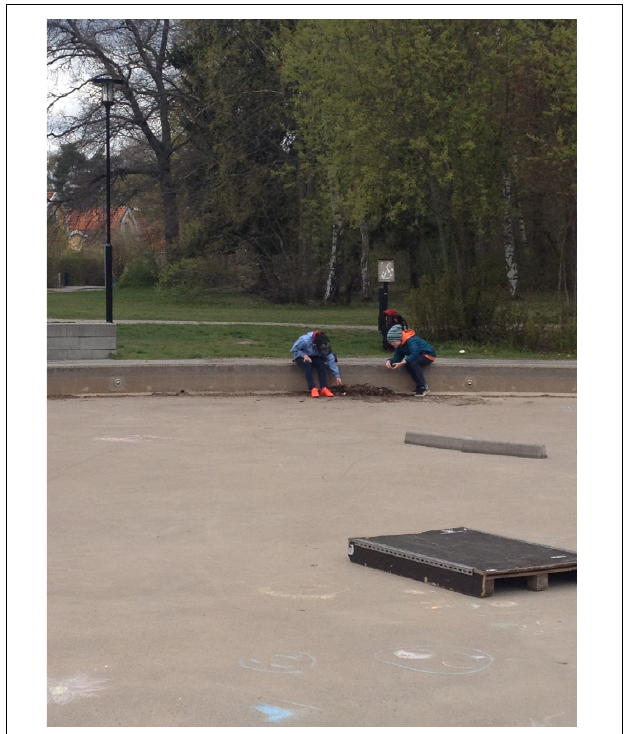
FIGURE 4 | Illustration of the authentic situation of the Salamander Project. Fourth graders searching for salamanders in a pile of leaves in the wading pool during the lunch break on a chilly spring day. Consent received from parents of the children. Photo: Sophie Belton.